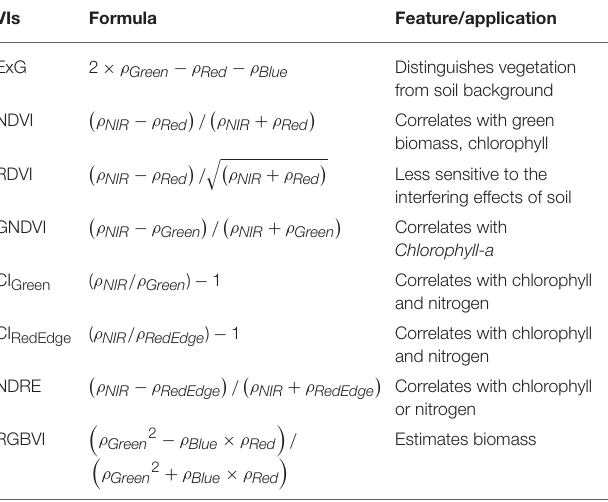
TABLE 2 | Formulas of vegetation indices used in this study. VIs Formula Feature/application